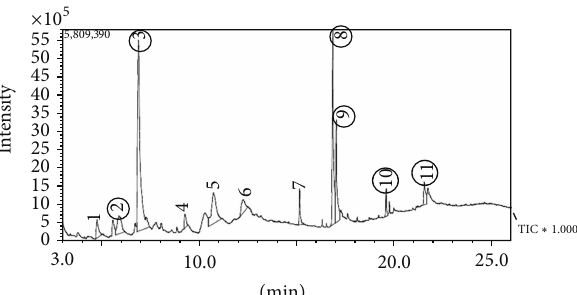
Figure 3: GC-MS analysis results of Acacia honey.